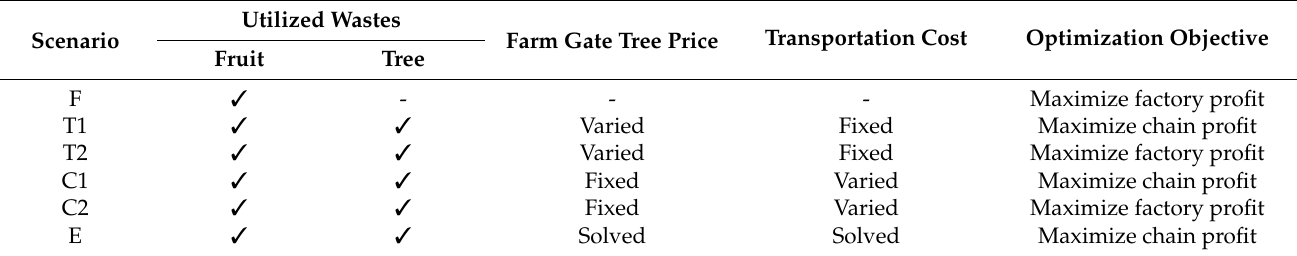
Table 1. Different scenarios presenting assumptions for banana wastes value chain development. The symbol (cid:51) indicates the type of banana waste to be used as